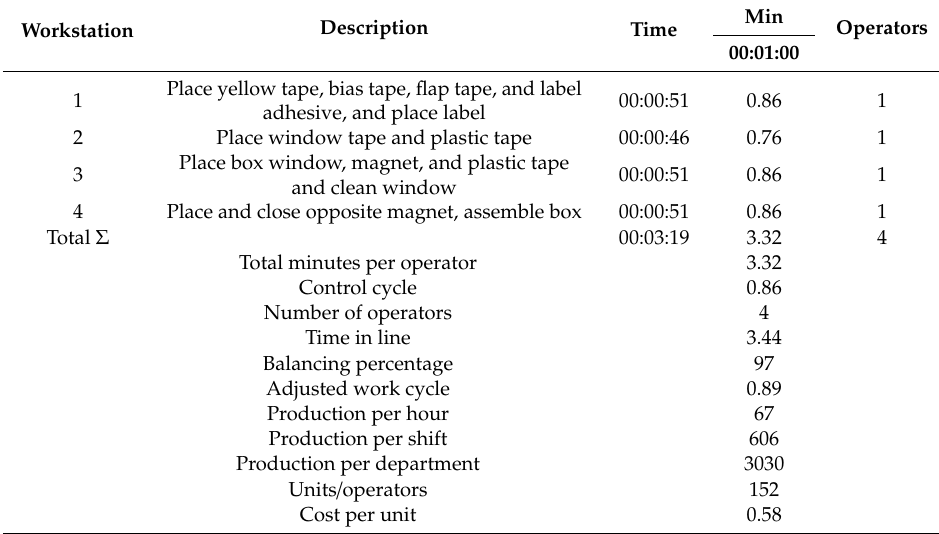
Table 9. Results of cost per unit—line balancing analysis in the redesigned